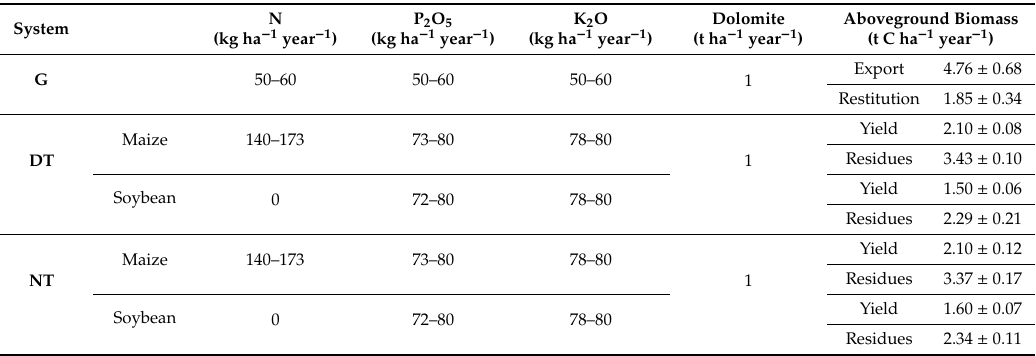
Table 1. Amounts of fertilizers (N, P 2 O 5 , and K 2 O) and dolomite (30% CaO, 20% MgO) added to the three agricultural systems (G: Grassland, DT: Disc tillage cropland, NT: No-tillage cropland) and aboveground biomass production (yields and residues left on the field). Means are computed for four crop cycles (2010–2014) and are followed by standard errors. Yields and residues of the mixture of legumes (in 2011) are included with soybean data. See Perrin et al. [40] for details. System